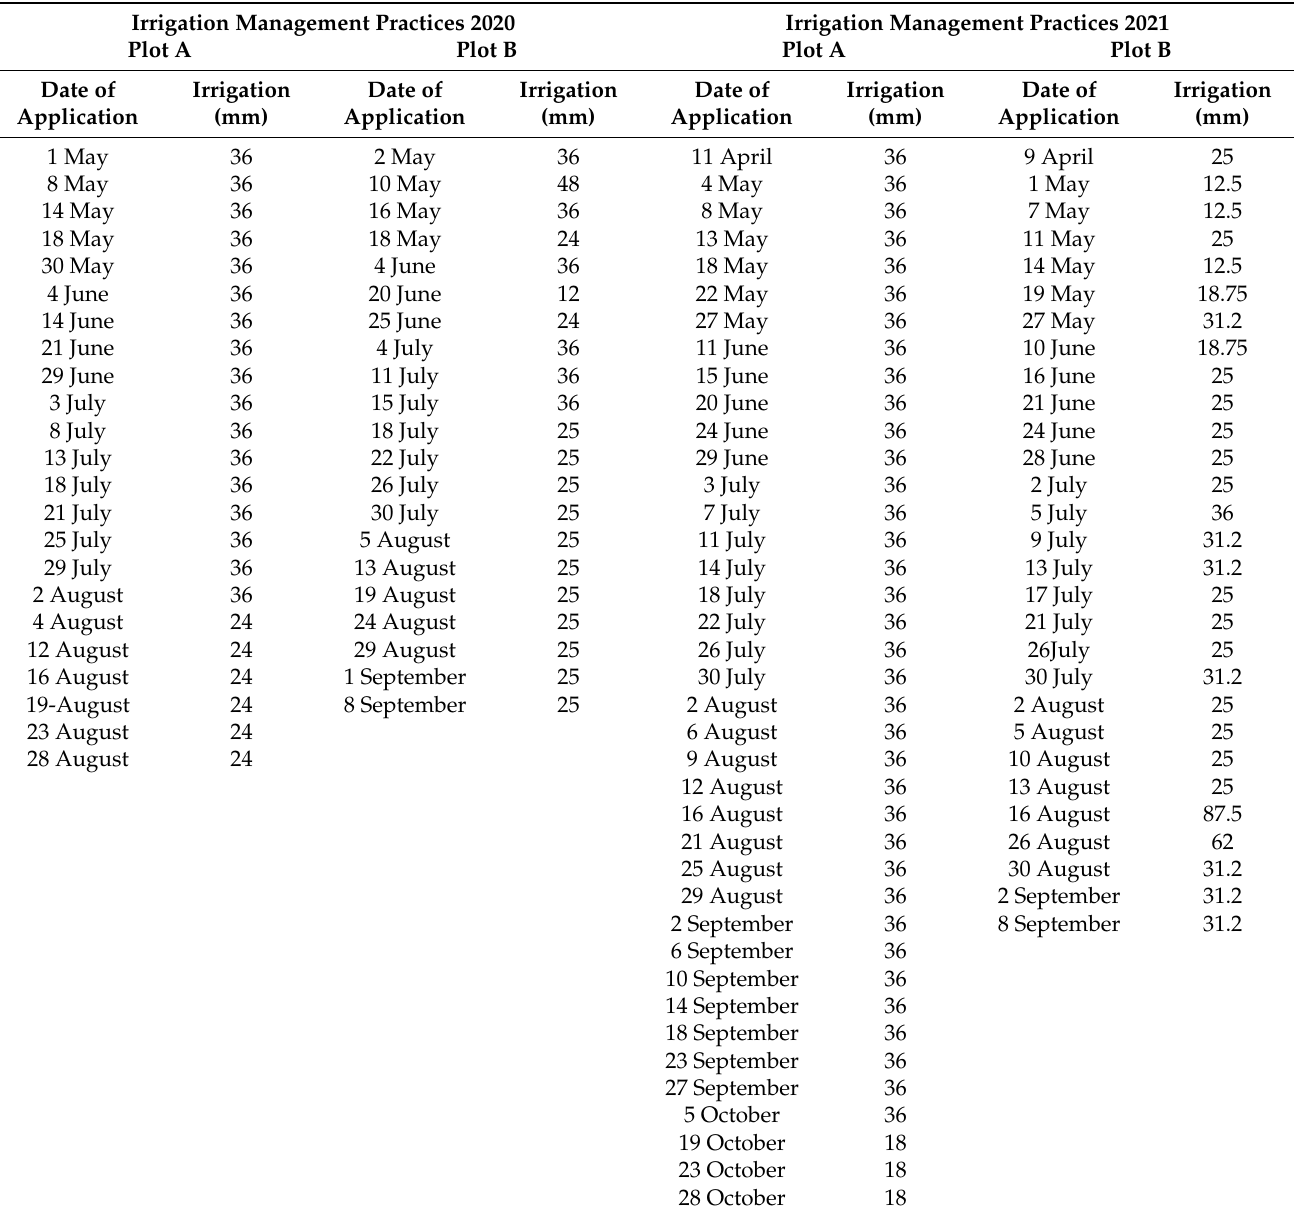
Table A1. Irrigation management calendars for plots A and B in 2020 and